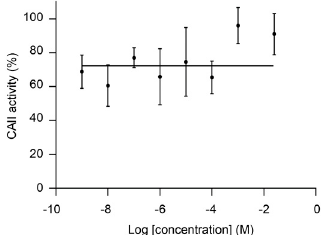
Figure 4. CAII inhibition by malotilate lacks a dose-response curve and thus data could not be well fitted by non-linear regression to calculate an IC 50 . Error bars represent the standard error of the mean of triplicate average values.